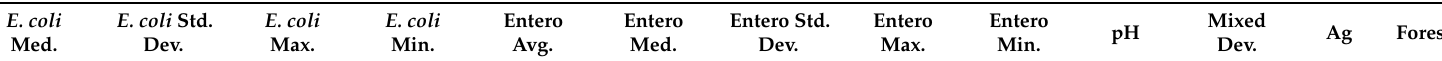
Mixed Entero Std. Entero Entero Ag Dev. Dev. Max. Min.